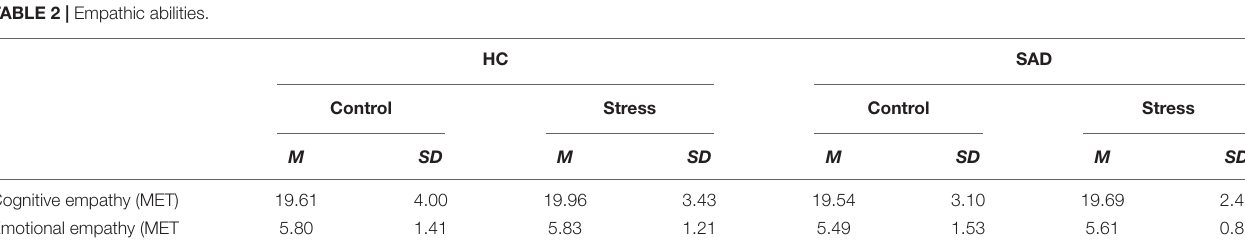
TABLE 2 | Empathic